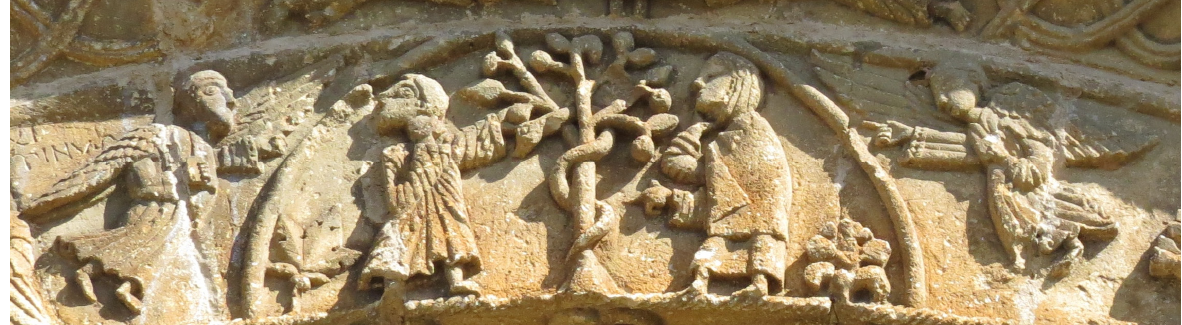
Figure 23. The Temptation and Fall of (clothed) Adam and Eve under the dome, detail of archivolt, west façade, Saint-Martin Church , 12th c., Besse, Dordogne, Nouvelle-Aquitaine, France. ©Author. Dubourg-Noves has identified Eve as the figure wearing the hood, but this is unlikely given the specific gestures associated with her and Adam (Dubourg-Noves 1982, p. 250). Therefore, I propose that Adam is carved on the sinister (left) of the tree and Eve on its dexter (right). 33 Picking the fruit from the tree with her left hand, Eve also touches the serpent’s head, while she holds another fruit close to her mouth in her right hand. Eve’s head is uncovered, and her face is turned towards one of the two angels flanking the dome. Wearing a hooded tunic, Adam places his left hand on his Adam’s apple as his right hand points toward Eve, blaming her for the Fall. Adam’s back is turned to the angel behind him, who also points at him and